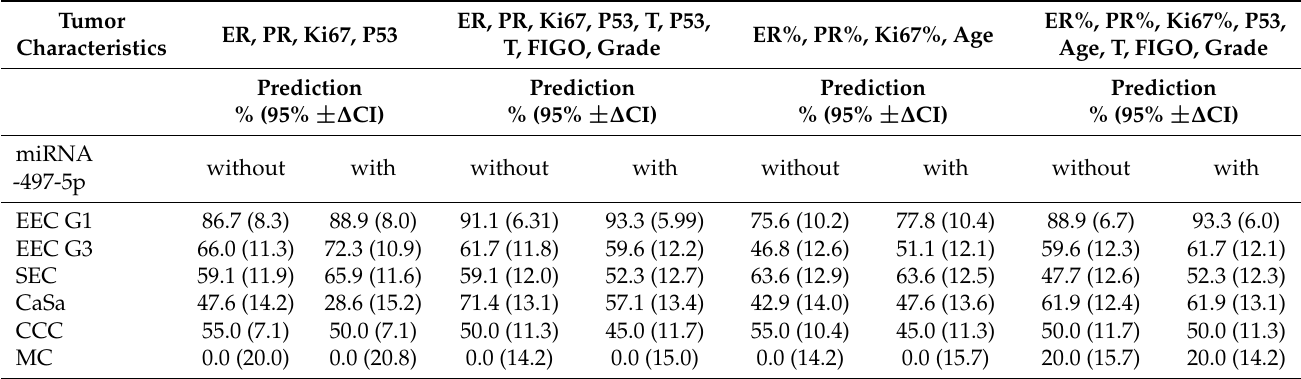
Table 5. Summarized confusion matrix results for SVM (support vector machine) and selected groups of clinical and histopathological characteristics of endometrial carcinoma. Tumor